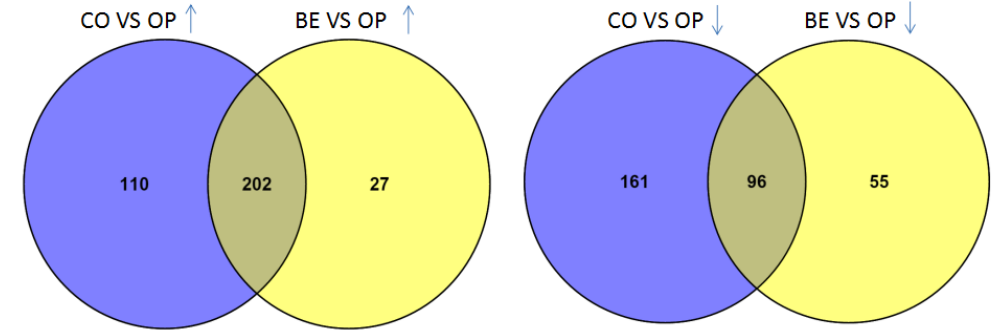
Figure 4. Venn diagram representing overlap between the two groups samples comparing all ion features found to be increased ( ↑ ) and decreased ( ↓ ) in O. unilateralis -infected mandible muscle samples based on p (corr) > 0.8 and p (corr) < − 0.8, respectively (CO: control; OP: O. unilateralis -infected ants; BE: B. bassiana -infected ants).